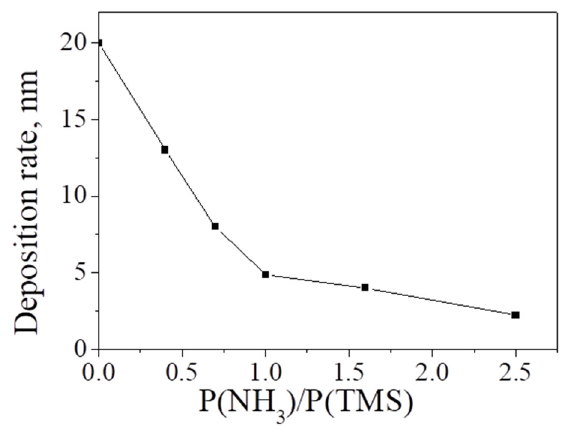
Figure 6. Deposition rate of SiC:H (SiCN:H) films deposited at 400 °C using various compositions of TMS/NH 3 initial gas mixture.